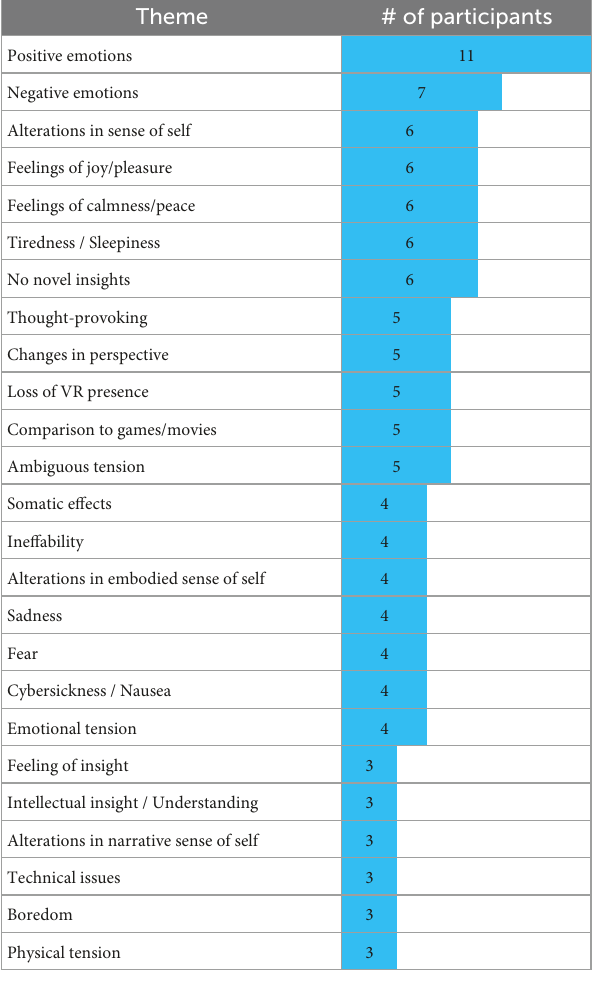
TABLE 2 Common themes found in the analysis of the semi-structured interviews ( n = 11). The colored bar plot indicates the proportion of participants who mentioned that theme in their